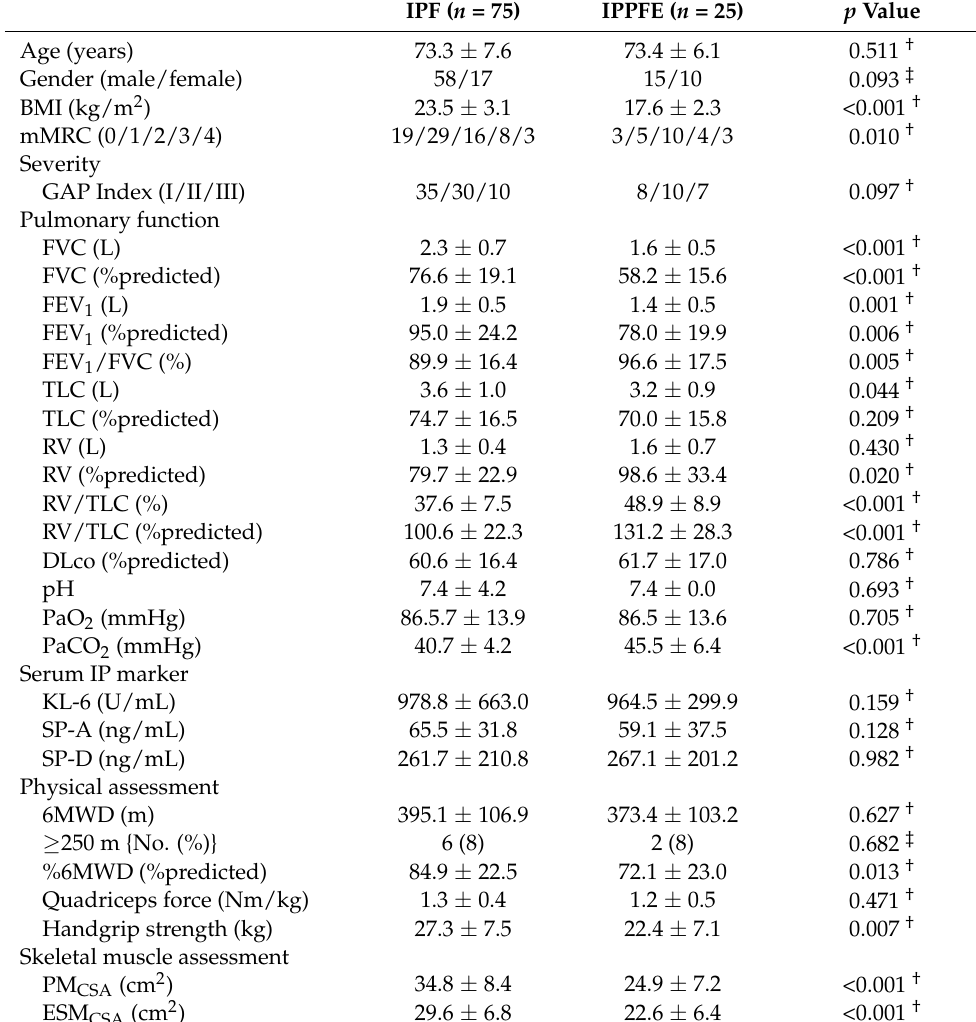
Table 1. Comparisons between IPF and IPPFE.